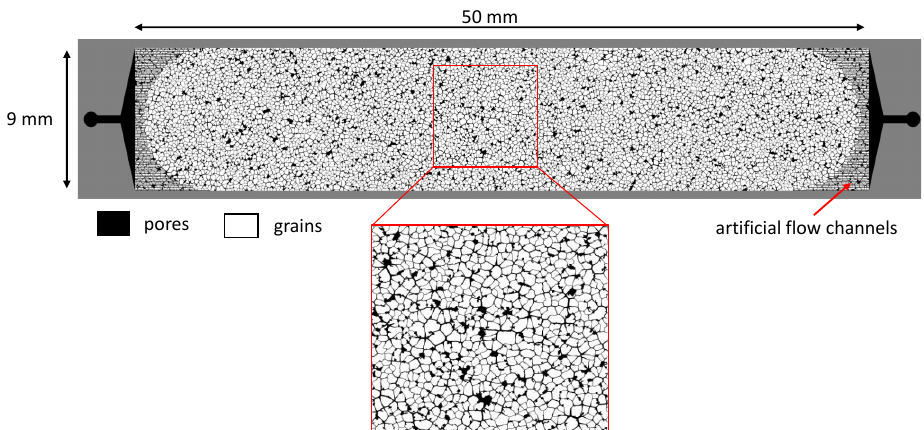
Figure 2. Structure of a microchip: The black color indicates the pores, flow channels and inlet and outlet boreholes. The white color represents the